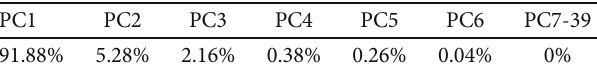
Table 6: Percentage of variance included in the 39 components of the PCA.